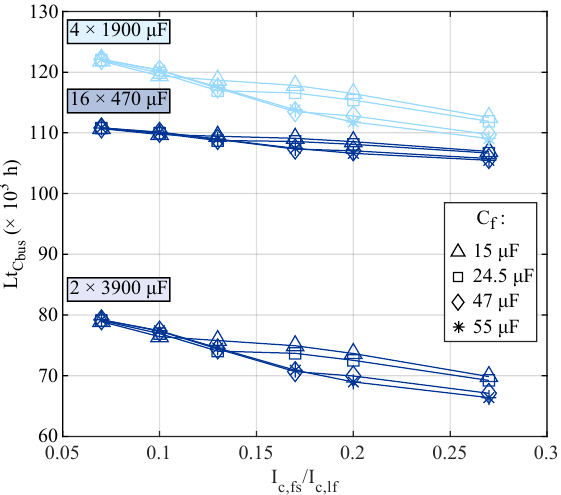
Figure 8. Estimated lifetime ( Lt C ) for each capacitor in the DC bus, as a function of I c , f bus As discussed in Section 4.2, when using C f = 24.5 µ F, the minimum volume for the LCL filter was obtained with I c , f / I c , lf = 17%, but the volume difference to I c , f s est value considered) was of 9.5%. Given the same capacitance value in the filter (24.5 µ F), and with 4 × 1900 µ F in the DC bus, the difference in Lt C 7% is of 4.4%. This difference in lifetime is smaller than what was found for Lt C was of 29%. Since using I c , f / I c , lf = 7% benefits both Lt C s